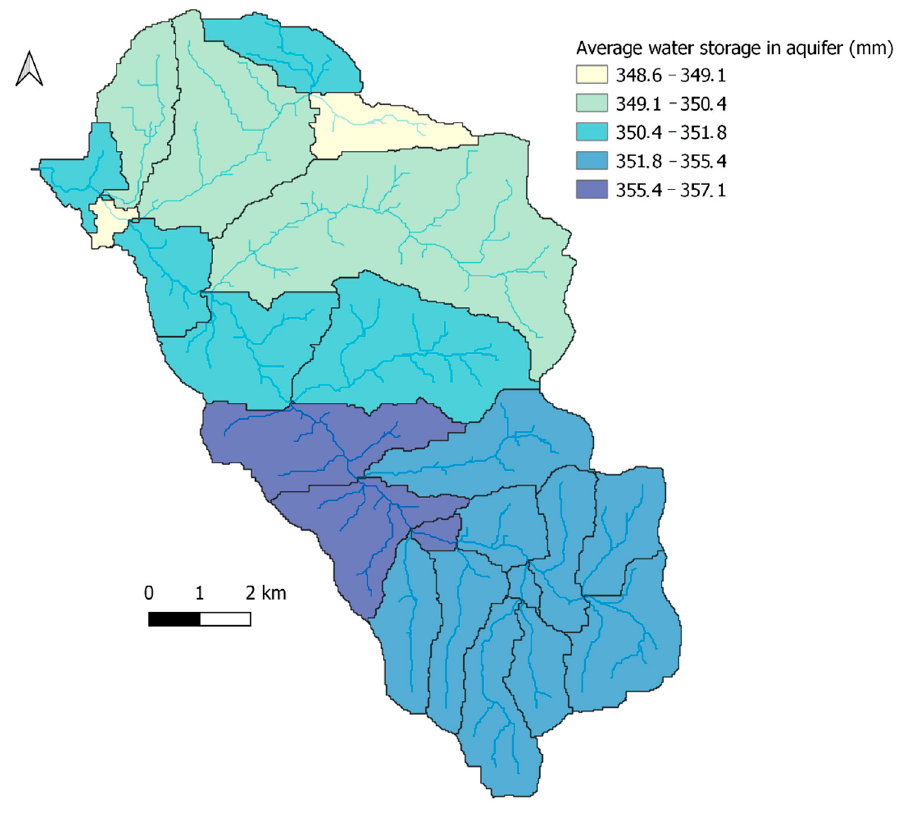
Figure 8. Level of aquifer water storage for Mszanka catchment.